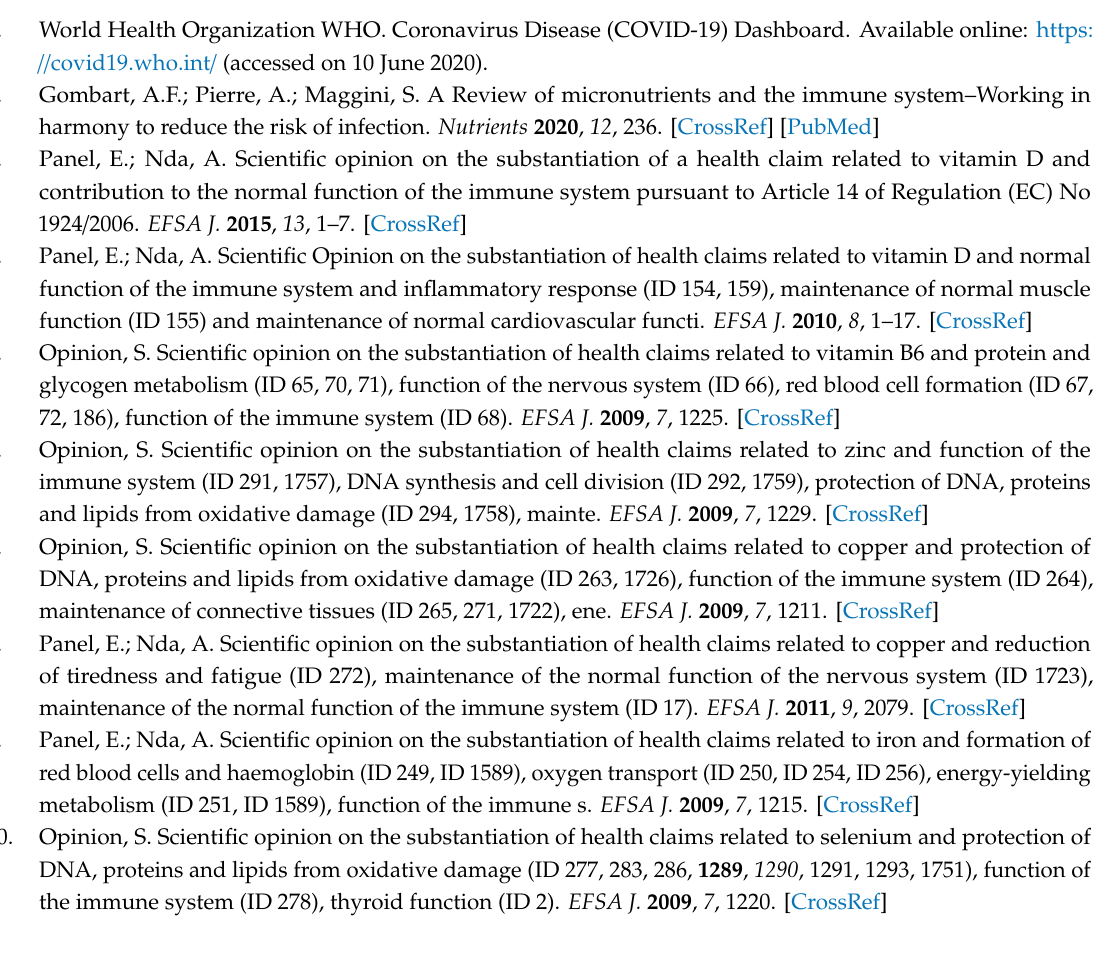
Supplementary Figure S1. Country genotype frequencies of Single Nucleotide Polymorphisms (SNPs) involved in specific Vitamins and Minerals nutritional